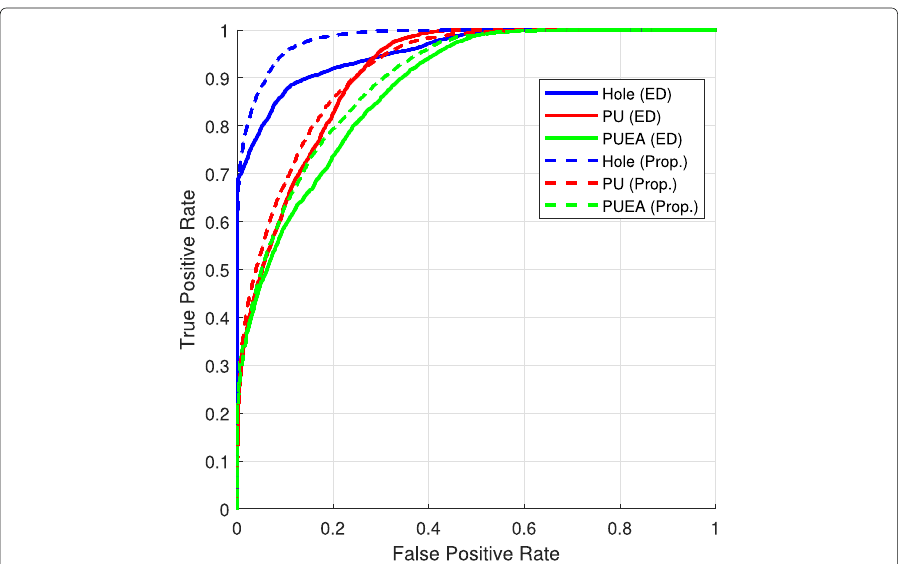
Fig. 4 Comparison of the proposed algorithm with the ED-based ML algorithm for PUEA detection using ROC curves